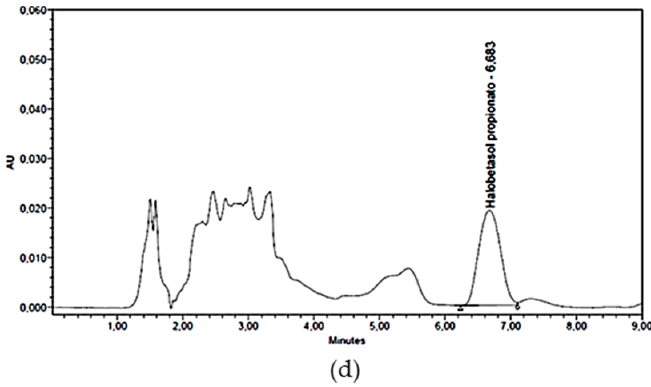
Figure 1. Chromatograms of ( a ) blank of T/w; ( b ) permeated T/w; ( c ) standard 25 µ g/mL halobetasol